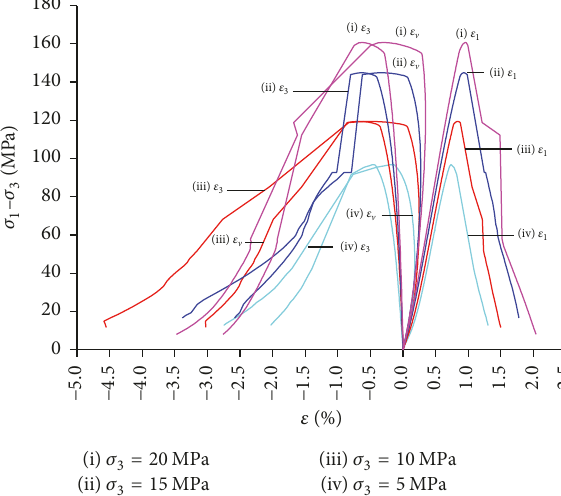
Figure 2: Complete stress-strain curves of rock samples under uniaxial and triaxial compression.